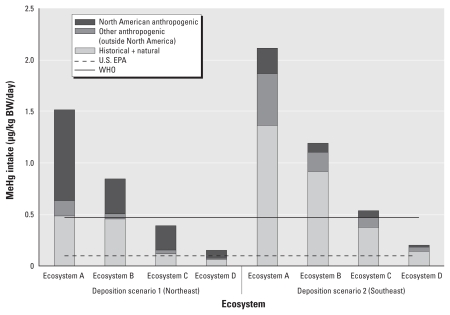
MeHg intake source attribution for a hypothetical consumer eating 0.7 g fish/kg body weight per day for the four model ecosystems under deposition scenarios 1 and 2. The solid line indicates the WHO maximum intake recommendation; the dashed line shows the U.S. EPA RfD.